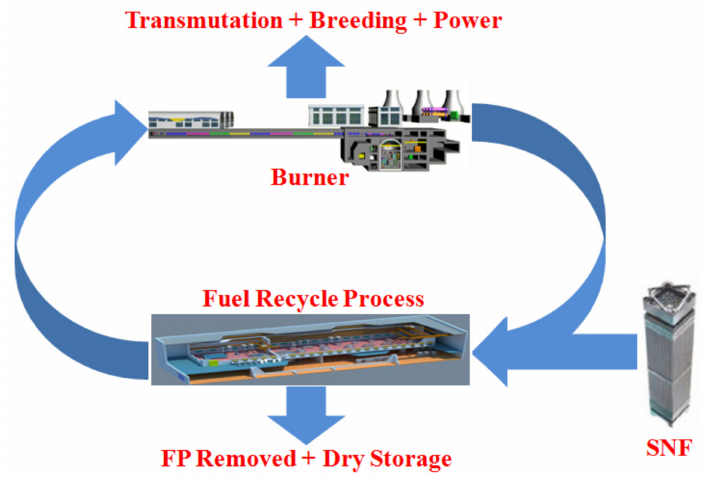
Figure 1. Schematic of the accelerator-driven advanced nuclear energy system (ADANES). FP: fission product; and SNF: spent nuclear